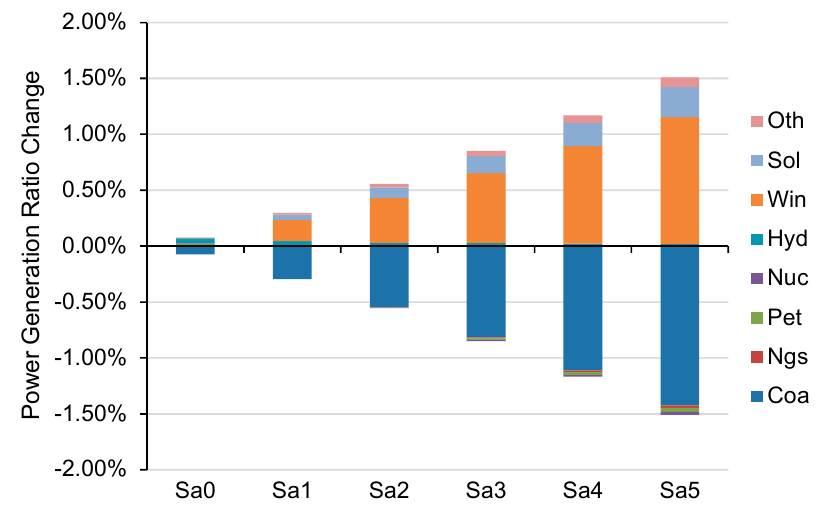
Figure 10. Power generation structural changes under different scenarios.